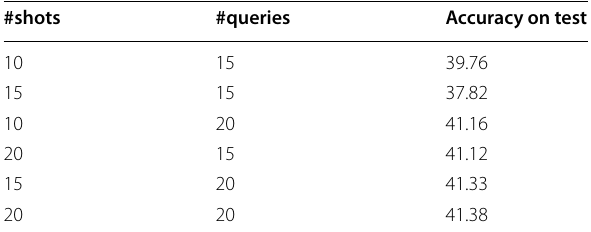
Table 7 Results on the 39 phonemes of TIMIT with the prototypical